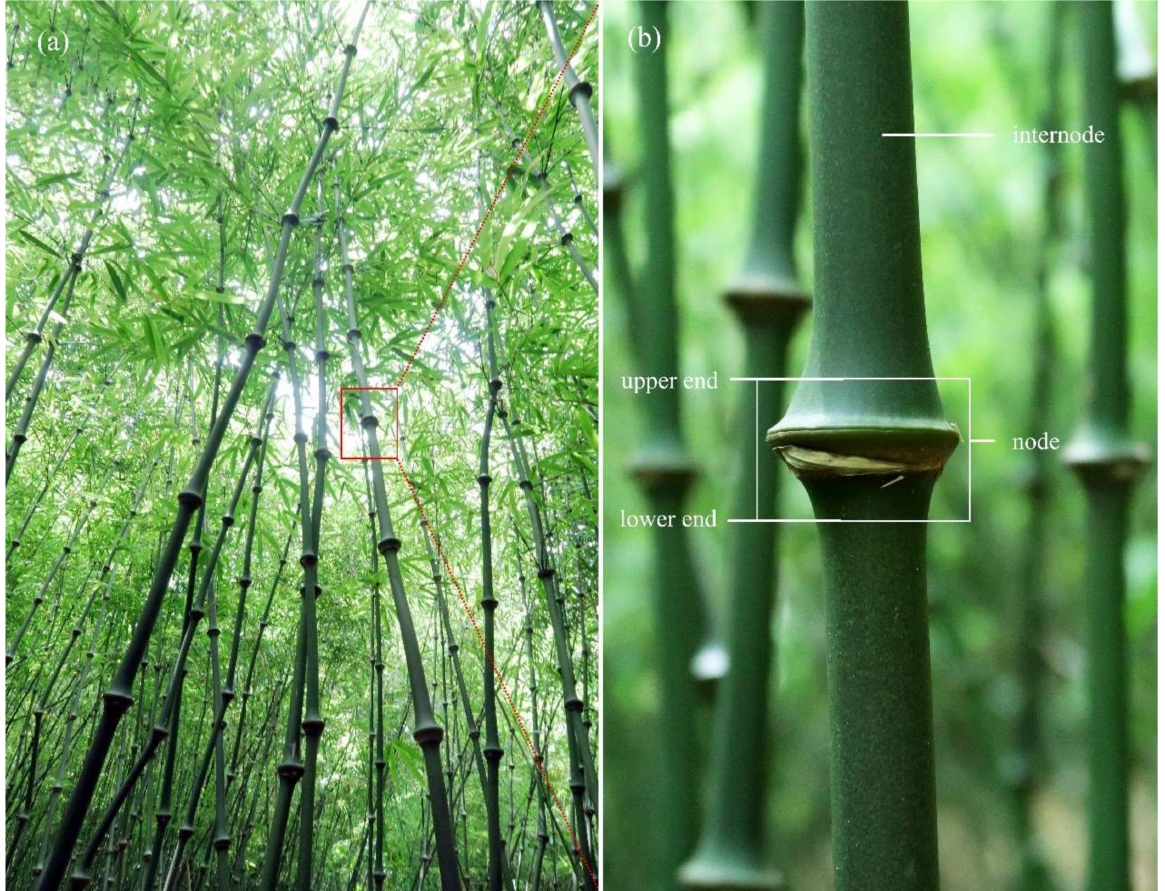
Figure 1. Preparation of µ CT sample. ( a ) Bamboo. ( b ) Sampling location (white wireframe